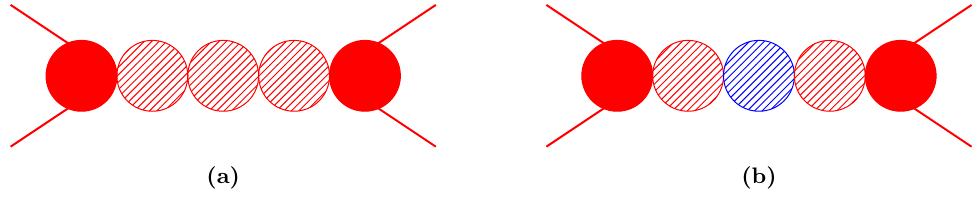
Figure 8. Examples of linear chains of blobs contributing to the vertex renormalization of a double trace coupling (here f 1